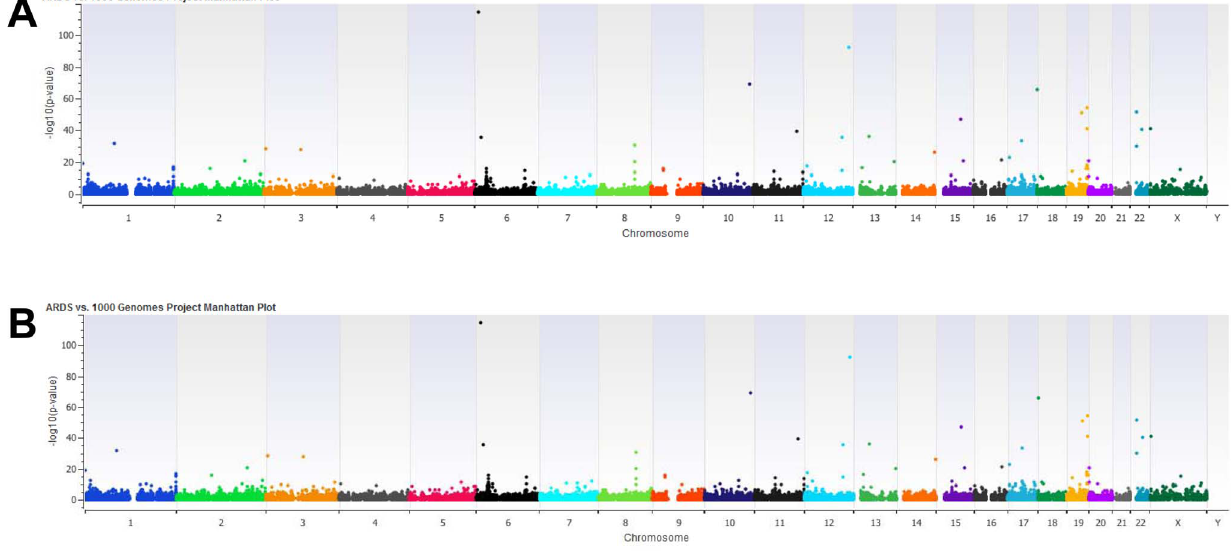
Figure 2. Manhattan plot of ARDS patients and 1000 genomes project controls. A number of strong associations with susceptibility to ARDS were observed using a x 2 test. ( A ) A Manhattan plot of the whole exome sequence all ARDS cases vs. European Ancestry and ASW 1000 Genomes Project controls created using SVS v8.2.0. This is a graphic representation of the chromosome location (x axis) vs. the –log10 ( x 2 p-value) of the allele frequencies. SNPs whose chi-square tests yield a smaller p-value fall higher on the log scale are more significant [42]. ( B ) The same Manhattan plot with a zoomed Y-axis.